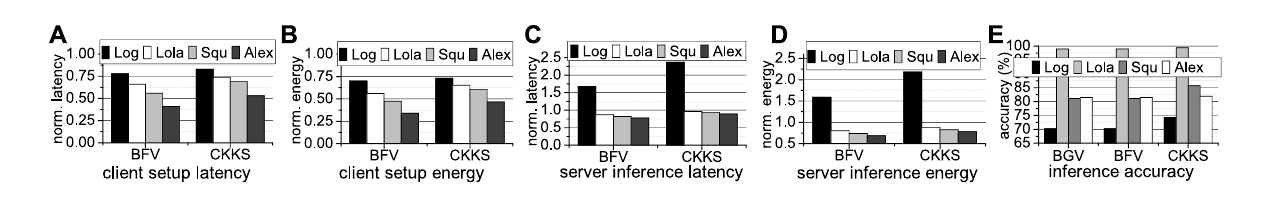
FIGURE 10 The latency, energy, and accuracy comparison of various FHE-based networks generated by our CoFHE compiler (A) : client setup latency; (B) : client setup energy; (C) : server inference latency; (D) : server inference energy; (E) : inference accuracy; all latency and energy results are normalized to